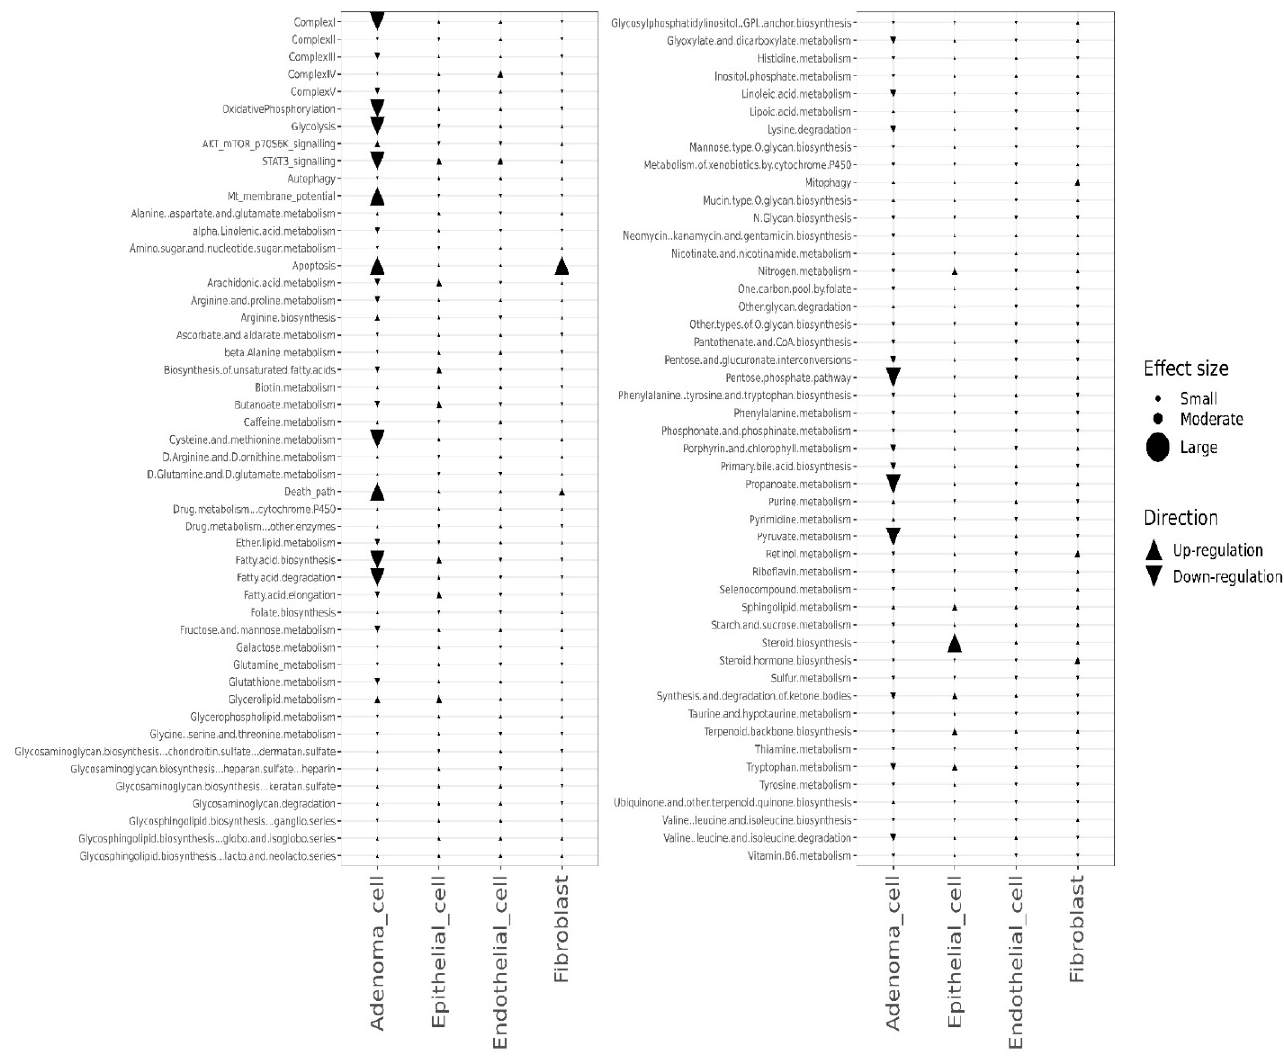
Figure 3. Pathway changes between control and Mito-HNK groups in the CD45 − cell populations. KEGG metabolism pathways and other pathways are compared between the control and Mito-HNK treated treatment groups.